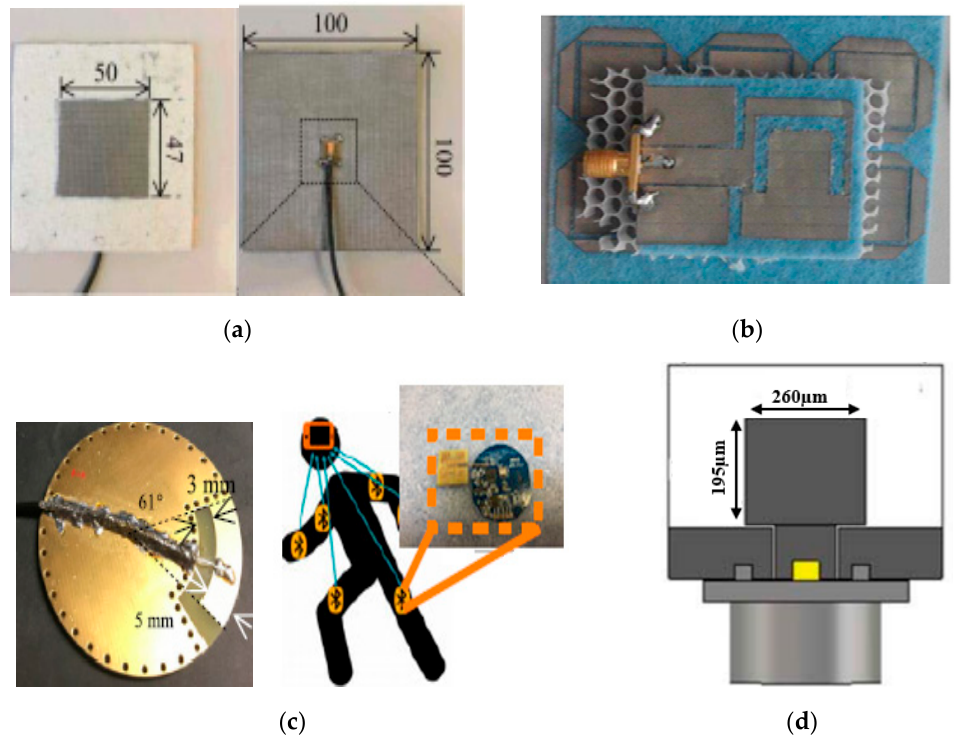
Figure 11. ( a ) Patch antenna with miniaturized feeding network [293], ( b ) AMC antenna [297], ( c ) mosaic antenna [308] , and ( d ) THz graphene antenna [312].